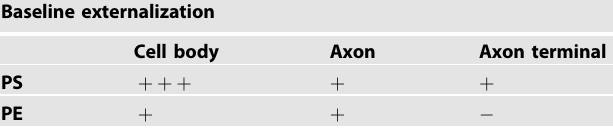
Table 1. Qualitative differences in phospholipid externalization in different cell regions at baseline.